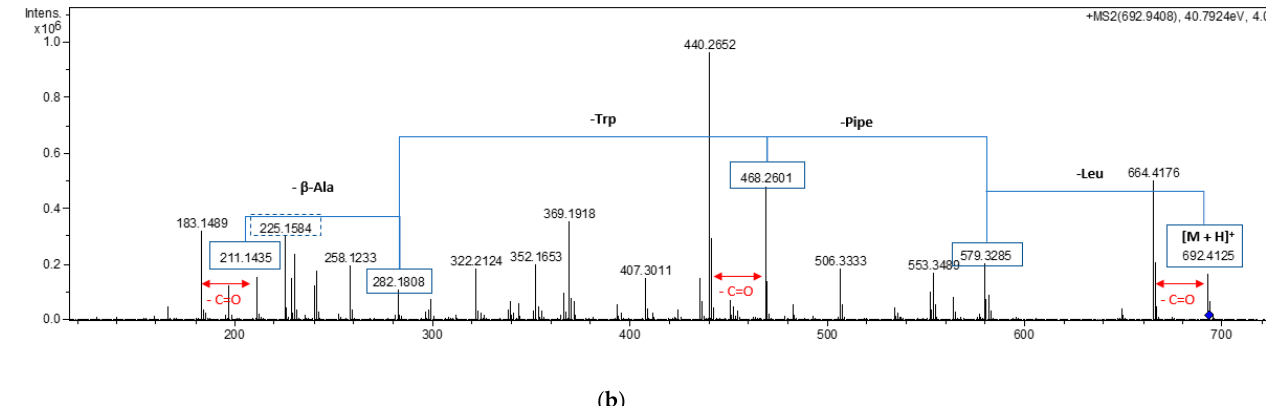
Figure 3. ESI-TOF MS/MS fragmentation of pipecolisporin ( 1 ). ( a ) Relevant fragments found. ( b ) MS/MS spectrum with the most relevant fragments highlighted.